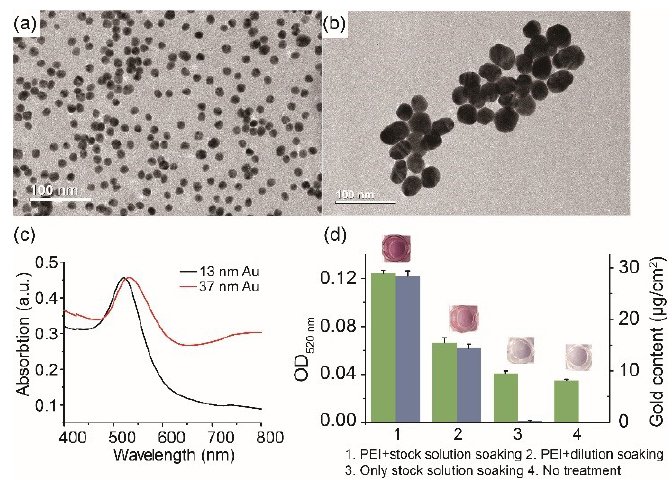
Figure 1. Characterization of gold nanoparticles (GNPs) and the GNP layer. Transmission electron microscope (TEM) image of 13 nm GNPs ( a ); TEM image of 37 nm GNPs ( b ); UV-Vis spectrum of GNPs ( c ); pictures with an optical density of 520 nm (OD 520 ) of the gold content of microplates treated three different ways and untreated microplates ( d